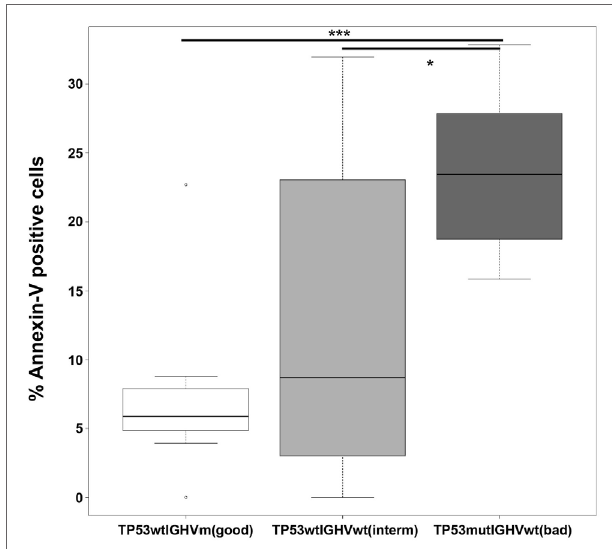
FigUre 5 | Poor prognosis B-cll cells are more susceptible to allogeneic r69-lcl-activated nK cells than good prognosis samples . R69-LCL-activated allogeneic NK cells (MACS enriched, > 90% CD56 + CD3 − cells; CTGreen labeled) were incubated for 4 h at 9:1 effector:target ratio with B-CLL cells from three groups of patients classified according to prognosis based on the mutational status of TP53 and IGHV (good: TP53 wt IGHV mut , n = 9; intermediate: TP53 wt IGHV wt , n = 8; bad: TP53 mut IGHV wt , n = 5). Subsequently, PS traslocation (annexin V DY634) and